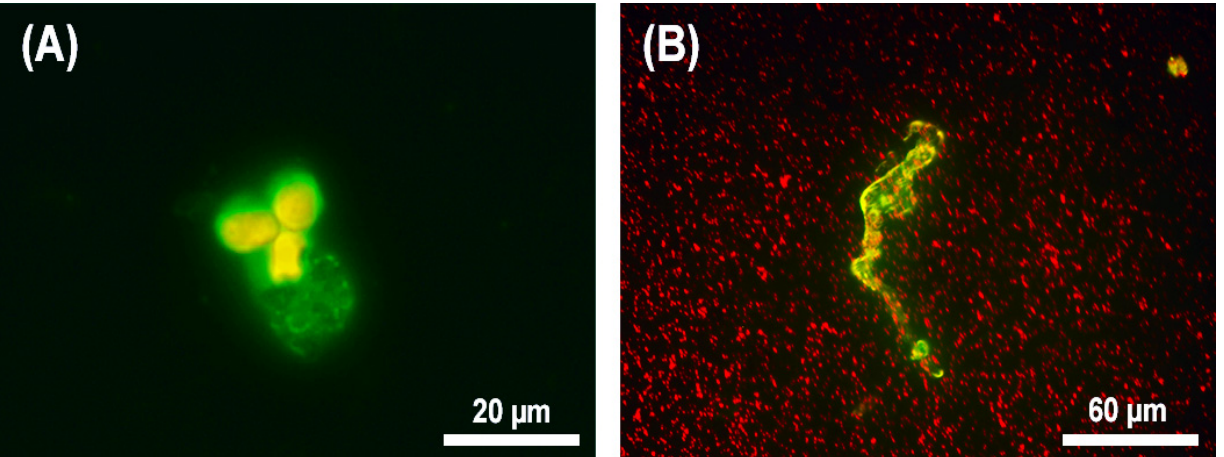
Figure 5. The neutrophil morphology after transendothelial migration in zone with S. aureus 2879 M. Neutrophils were stained with propidium iodide and FITC-labeled myeloperoxidase antibodies, and bacteria were used in concentrations of 2.5 × 10 7 cells/mL (up to 100 bacterial cells per 1 neutrophil in the case of about 10% migration rate): ( A ) Fast NETosis (neutrophil survived); ( B ) classical NETosis (neutrophil died).